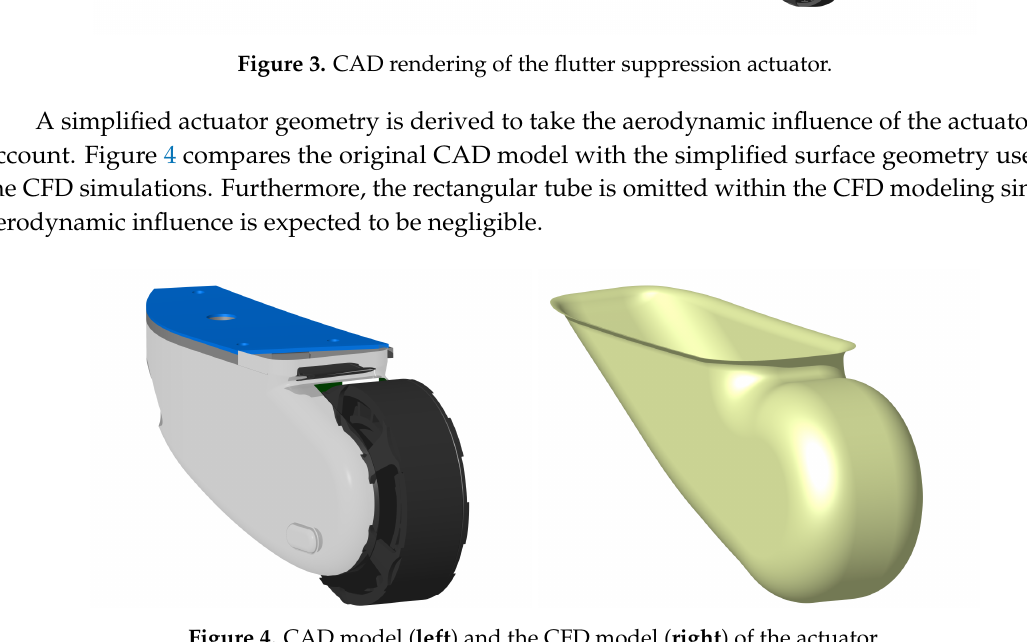
Figure 4. CAD model ( left ) and the CFD model ( right ) of the